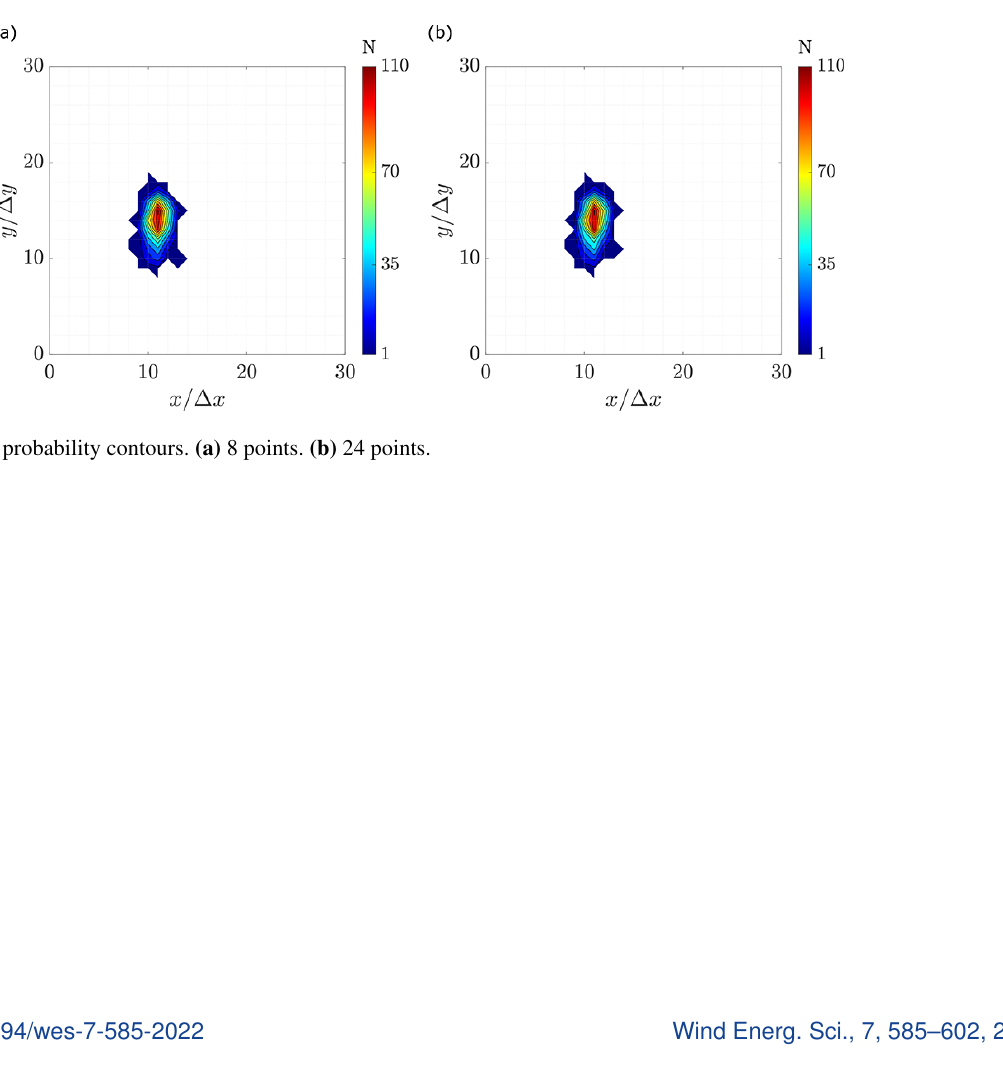
A2 Probability contours